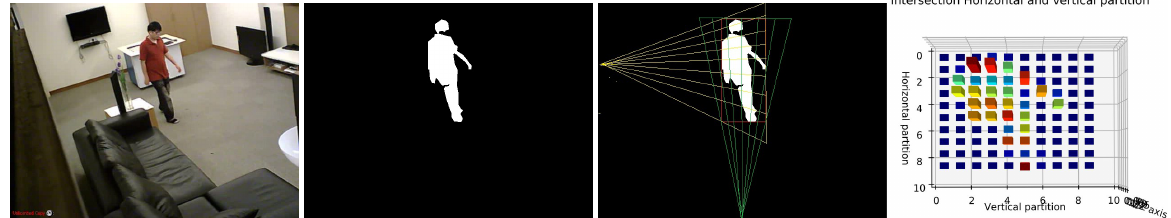
Figure 5. Illustration of the shape representation. First and second frames represent the original and human silhouette respectively. Third and fourth frame illustrate horizontal and vertical area partitions and corresponding histogram chart respectively.